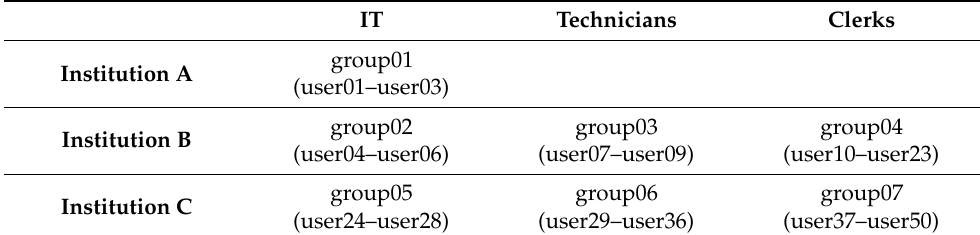
Table 2. Groups of Users Participating in The Evaluation Campaign.